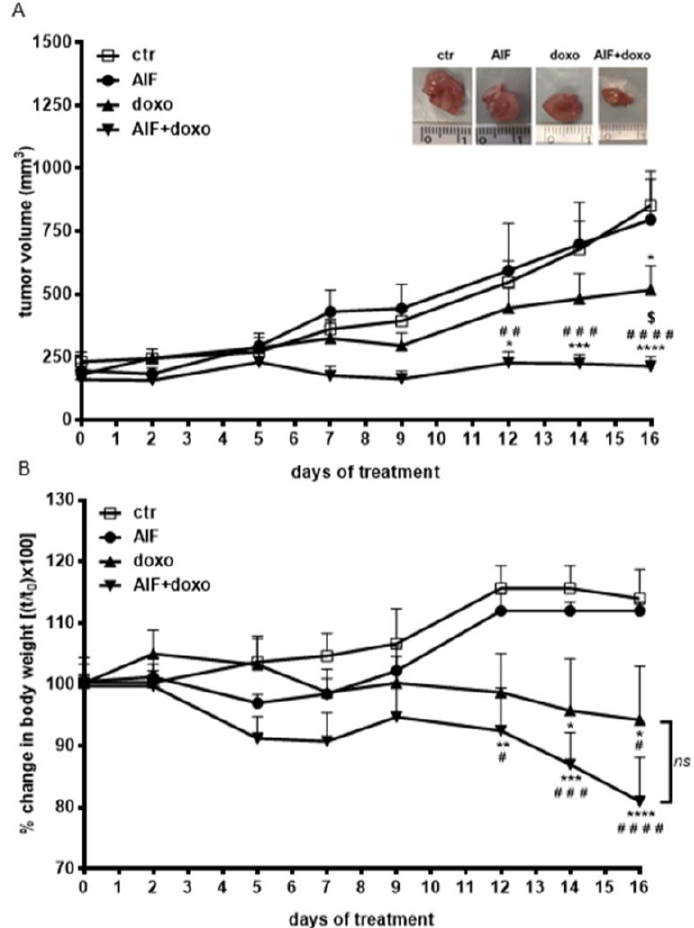
Figure 5. Effect of AIF-1 and doxorubicin treatment on a SKMES-1 tumor xenograft. ( A ) SKMES-1 cells were implanted s.c. on BALB/c-nude mice, and after tumors had reached an average size of approximately 200 mm 3 , the animals were randomized into four different groups. AIF-1 (25 mg/kg) was administered s.c. every day, and doxorubicin (4 mg/kg) was administered i.p. once a day, three times per week. Tumor sizes were measured two times per week, and data are expressed as mean tumor volume ± SEM of 8 tumors (* p < 0.05, *** p < 0.001, **** p < 0.0001 vs. ctr; ## p < 0.01; ### p < 0.001, #### p < 0.0001 vs. AIF; $ p < 0.05 vs. doxorubicin; two-way repeated measures analysis of variance followed by Bonferroni’s post-test). (Inset) Representative images of dissected xenograft tumors. ( B ) At the indicated time points, percentage change in body weight was calculated in all mice as (weight on day x/weight on day zero) × 100, and data are expressed as mean ± SEM (n = 8). * p < 0.05, ** p < 0.01, *** p < 0.001, **** p < 0.0001 vs. ctr; # p < 0.05, ### p < 0.001, #### p < 0.0001 vs. AIF; ns: not significant; two-way repeated- measures analysis of variance followed by Bonferroni’s pos t- test.